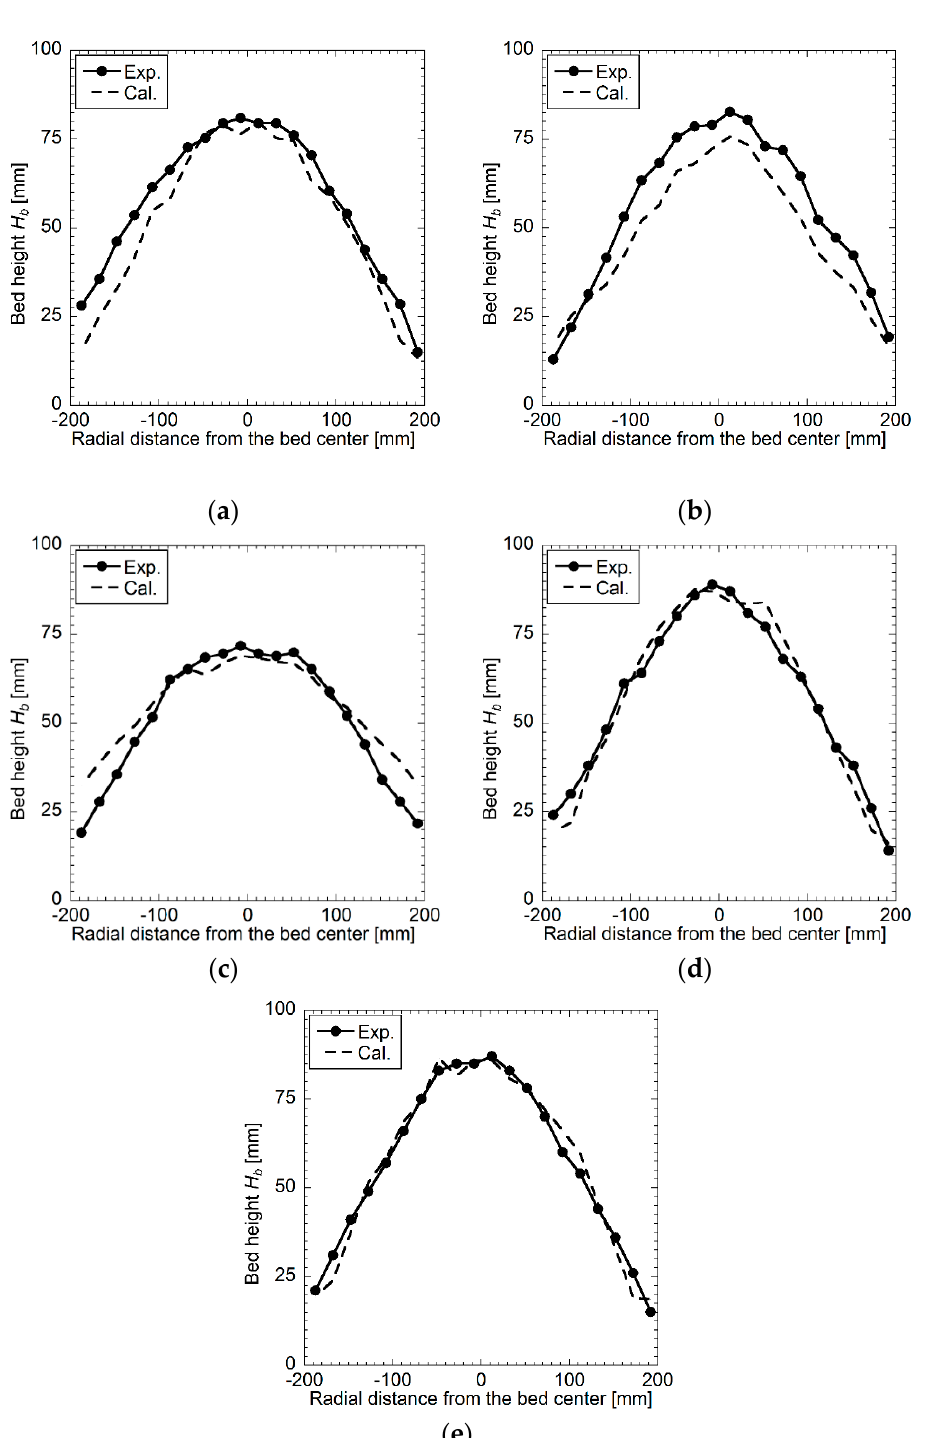
Figure 6. Radial variation of bed height for mixed particles with different properties in the radial direction: ( a ) Case M1; ( b ) Case M2; ( c ) Case M3; ( d ) Case M4; ( e ) Case M5.